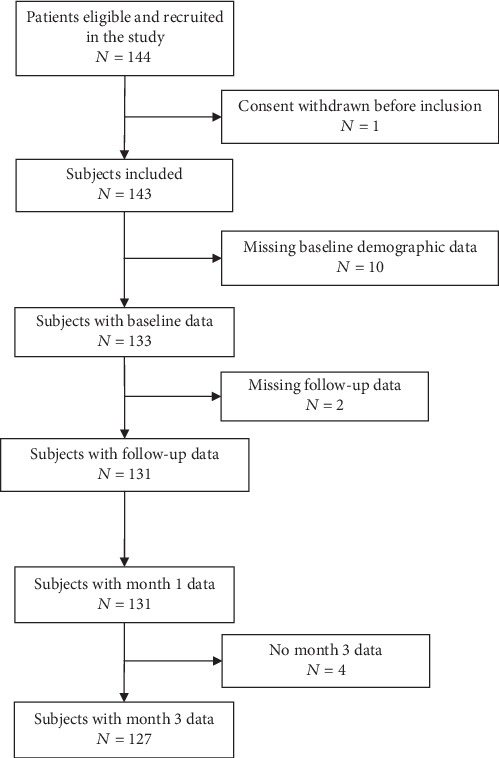
Study flow of subjects.